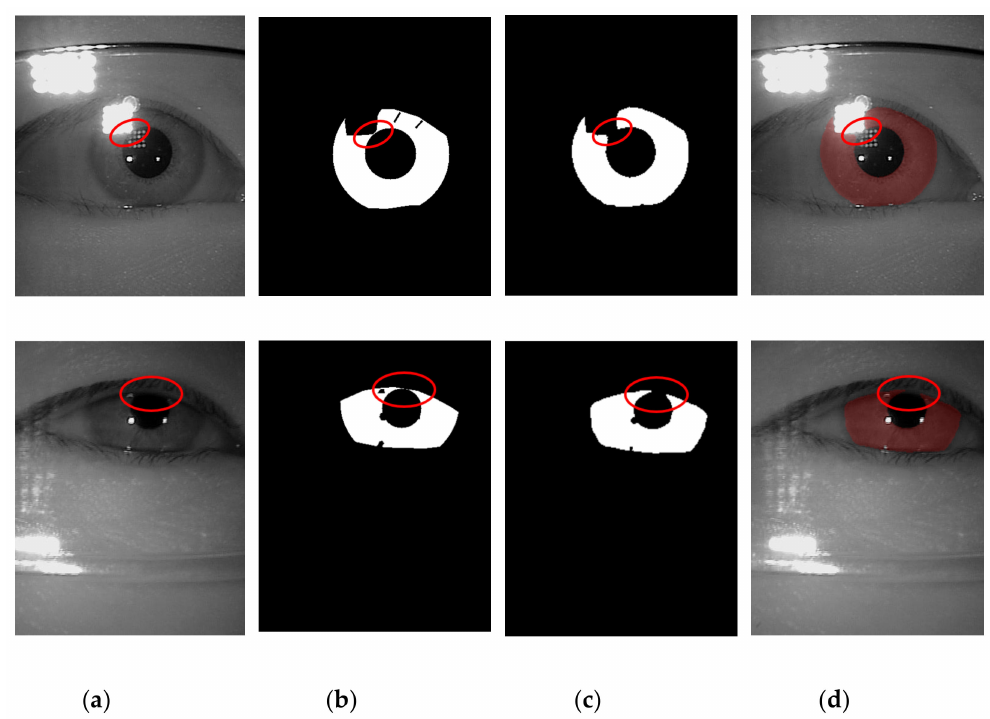
Figure 19. A pictorial example to show the robustness of the proposed method on the challenging images. ( a ) The input image; ( b ) the ground-truth masks; ( c ) the predicted masks; ( d ) the segmentation result plotted on the input